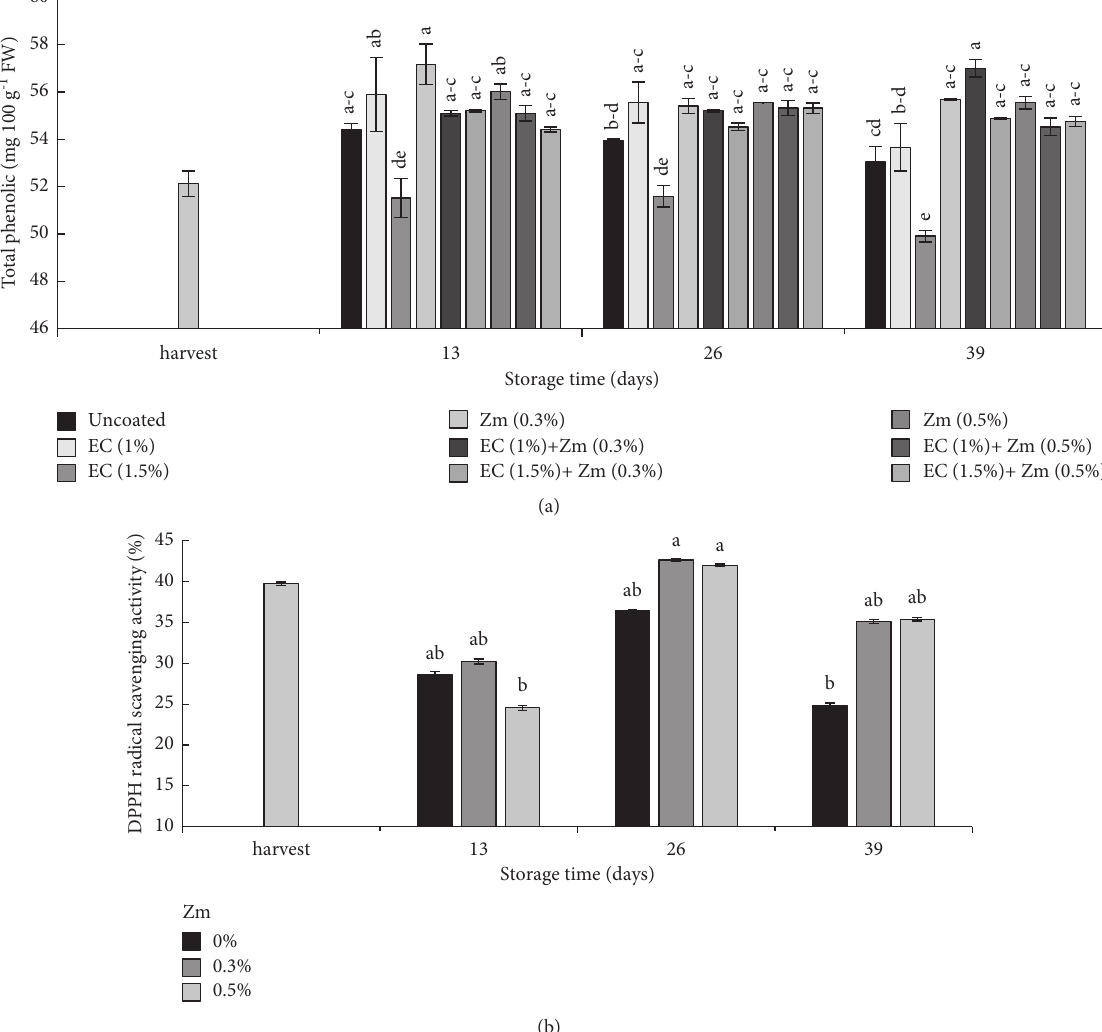
Figure 1: Total phenolics (a) of the fresh pistachio hull coated with sodium alginate+ Zataria multiflora and DPPH radical scavenging activity (b) in the fresh pistachio hull treated with Zataria multiflora during storage at 3 ± 1 ° C. Means ( n � 3) with the same letters are not significantly different according to Duncan’s test ( p < 0 . 05 ) . EC: alginate-based edible coating; Zm: Zataria multiflora